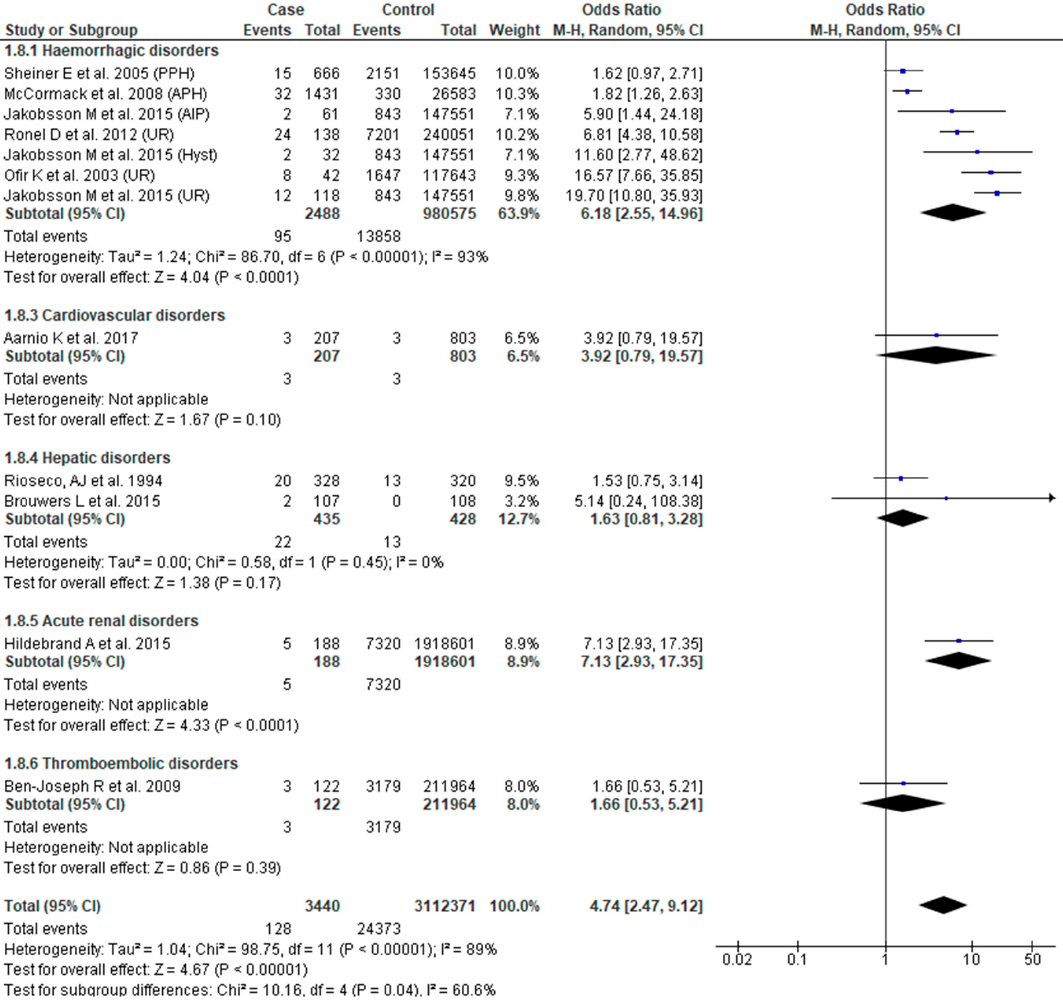
Figure 9. Forest plot of studies assessing association between Severe maternal morbidity (SMM) and perinatal death.